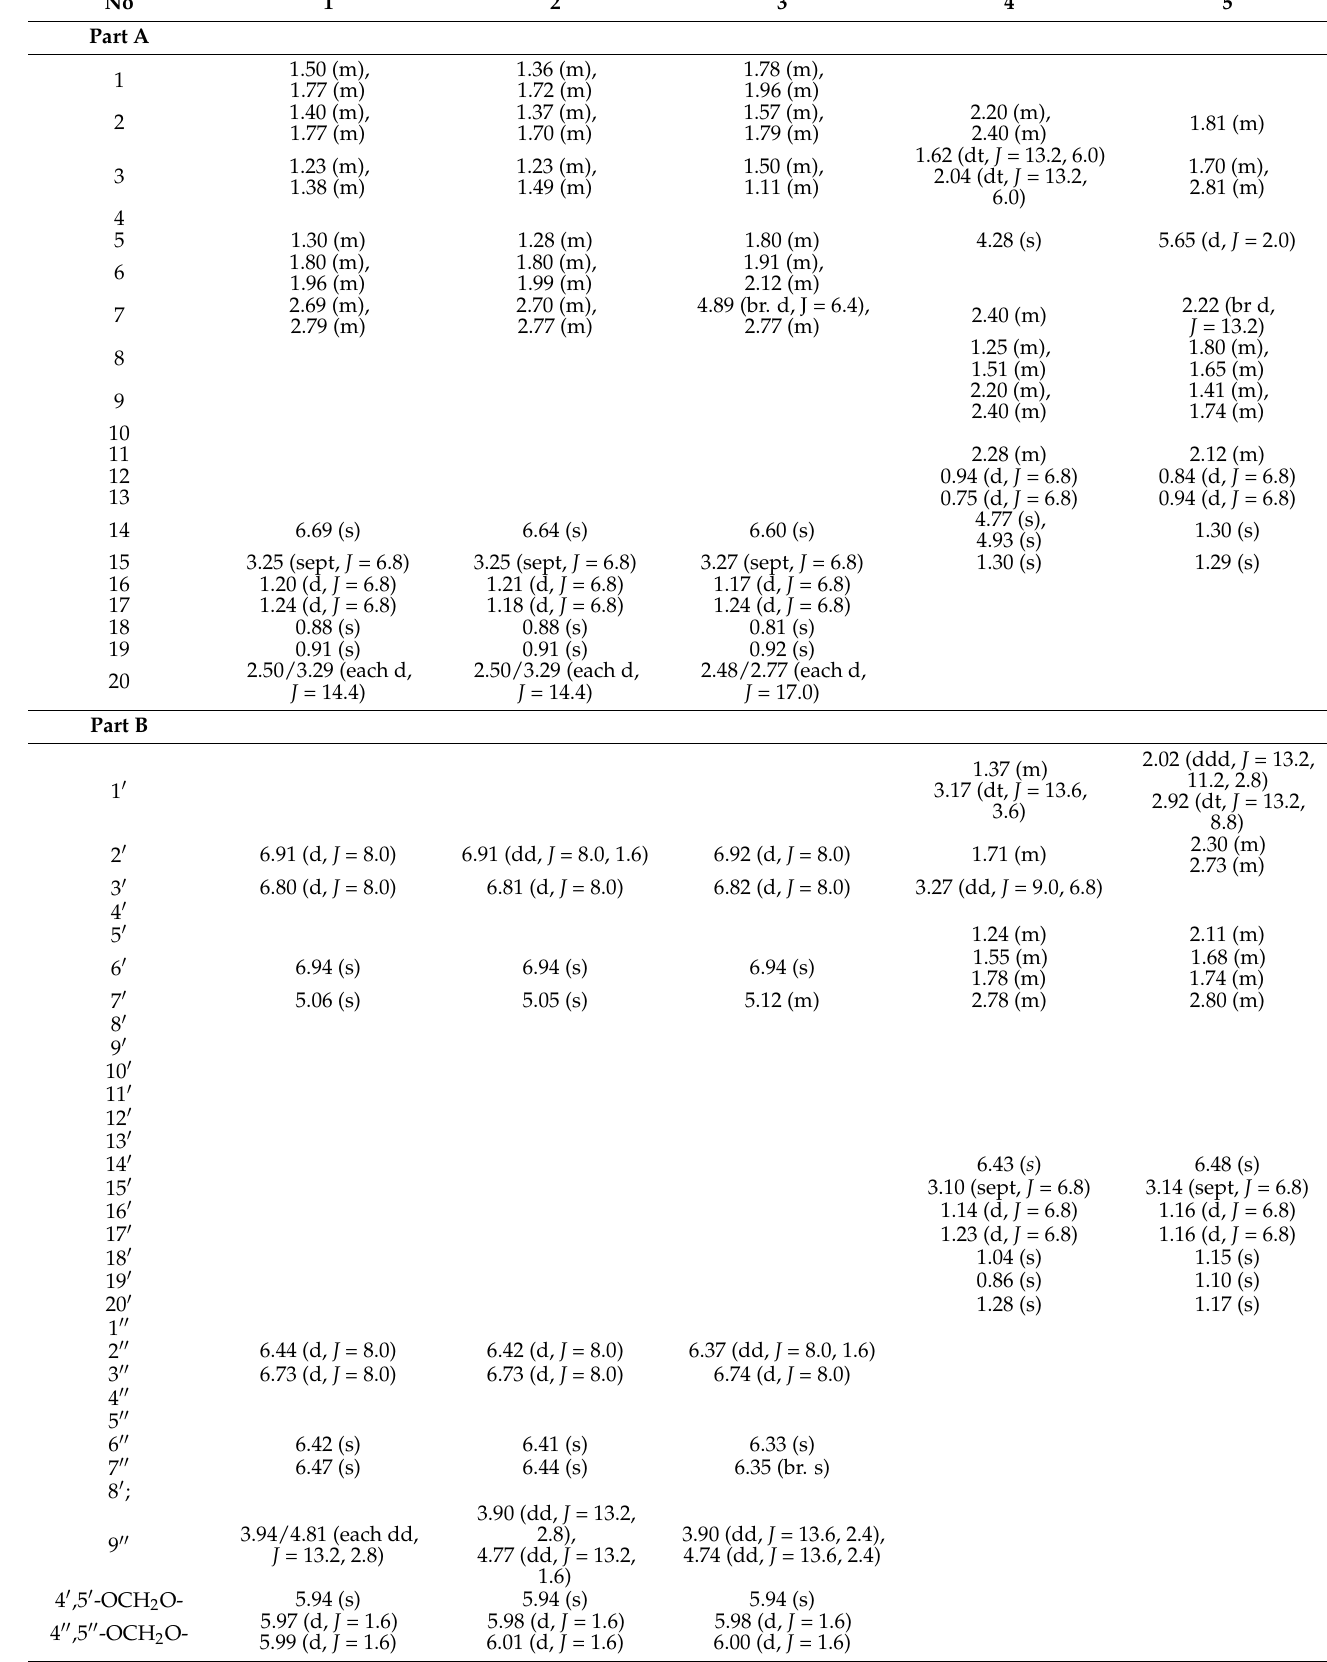
Table 1. 1 H NMR data for compounds 1 – 5 in CDCl 3 ( δ in ppm, J in Hz, 500 MHz in CDCl 3